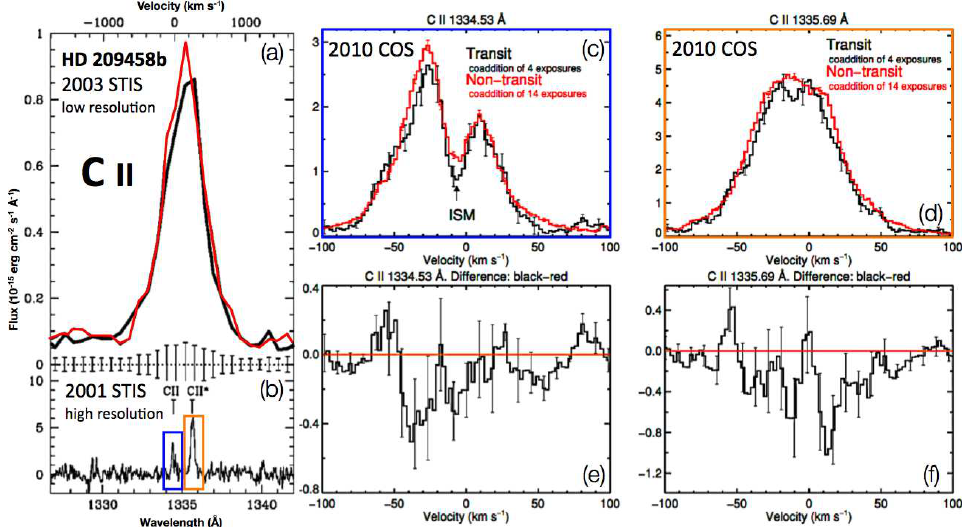
Figure 2: In-transit absorptions in the C ii doublet. (a) Low-resolution data of the with the in-transit (black) and out-of-transit (red) stellar emission (Vidal-Madjar et al. 2004). (b) High-resolution STIS spectrum. (c,d) High-resolution COS spectra of both components of the C ii doublet. (e,f) Subtractions of the black and red curves from panel (c) and (d), showing the velocity structure in the exospheric absorptions